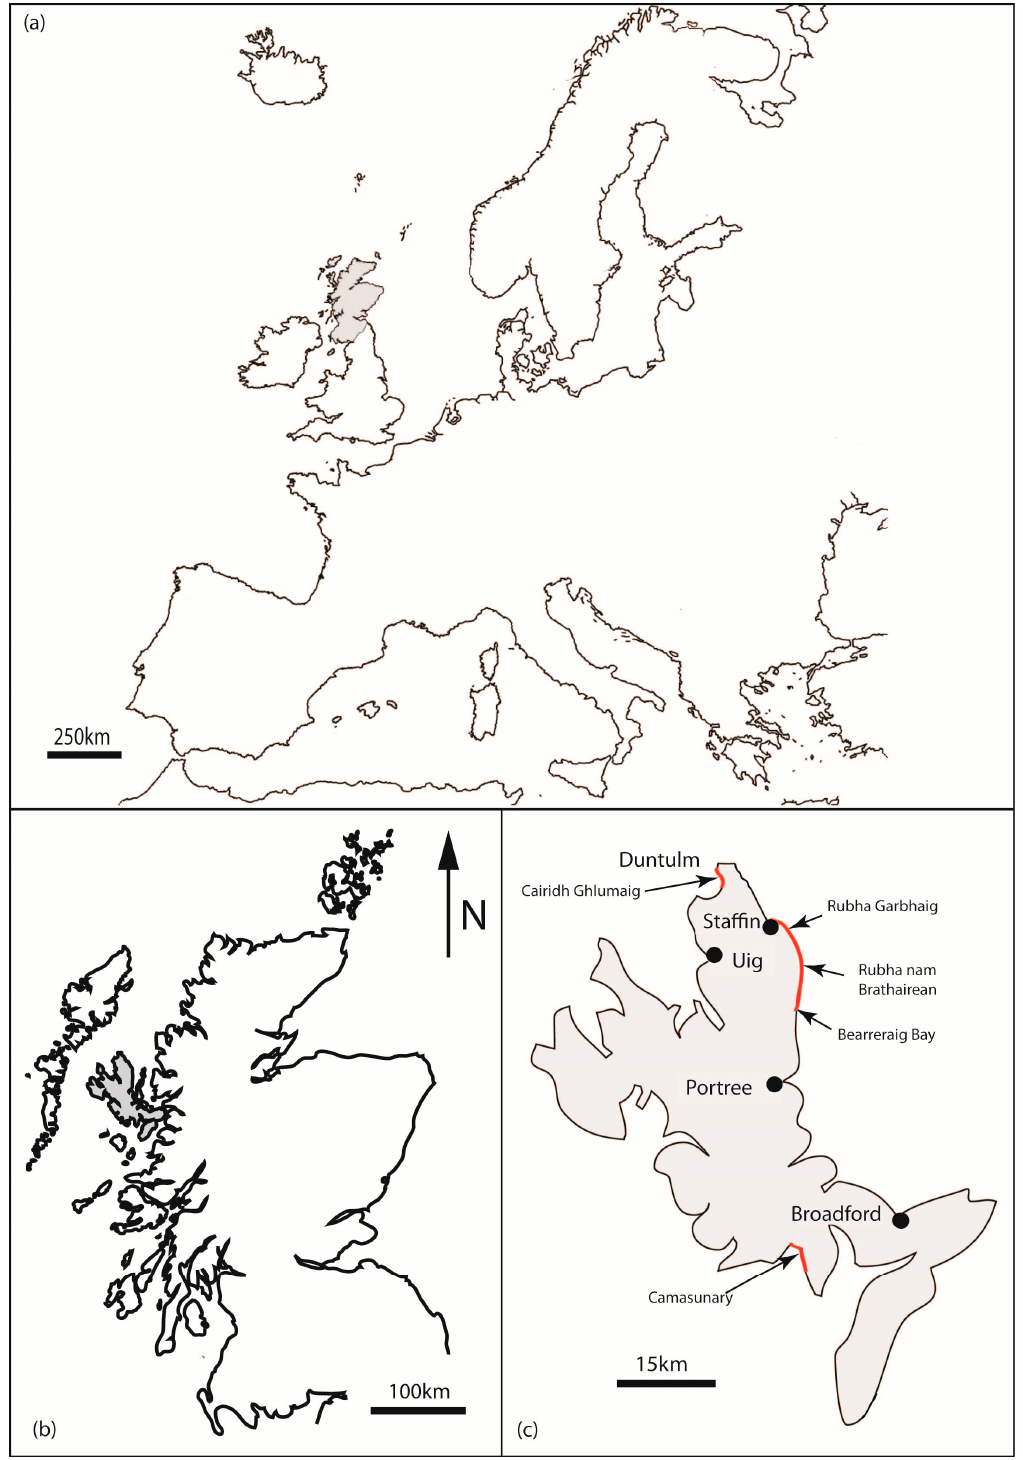
Figure 1. ( a ) Map of Europe with the position of Scotland highlighted; ( b ) map of Scotland showing the location of the Isle of Skye and ( c ) known dinosaur-bearing localities.